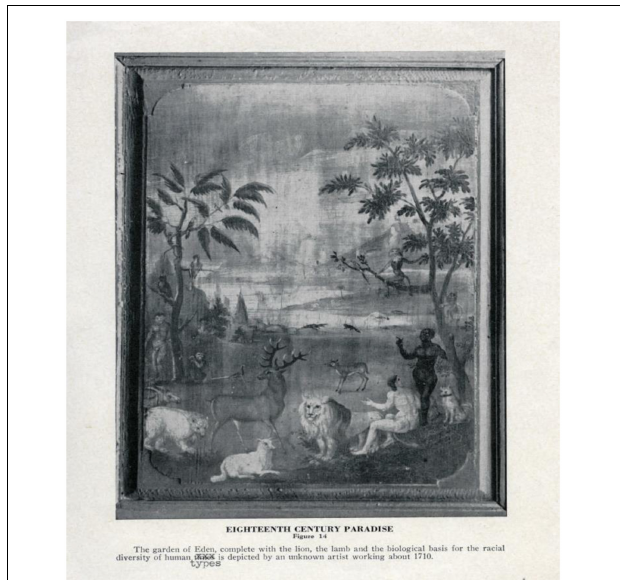
FIGURE 1 | Painting from around 1710, on a door-panel of the Alte Apotheke in southern Germany’s Calow’s pharmacy (Stern and Belar,